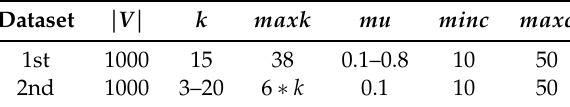
Table 3. Characteristics of synthetic